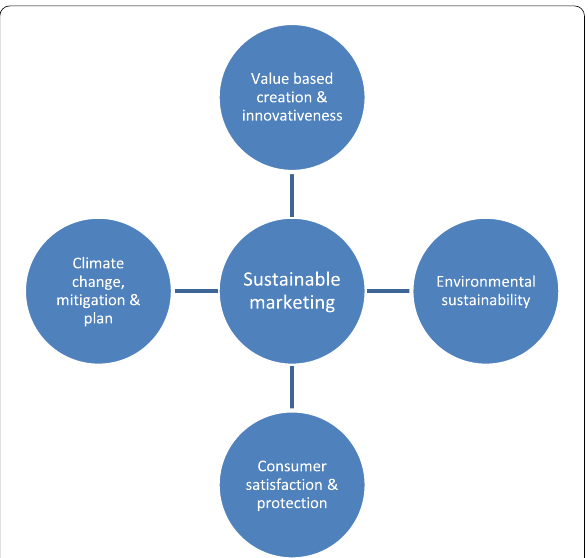
Fig. 4 Proposed model of sustainable marketing by chart representation. Author source: Model of sustainable marketing by chart representation